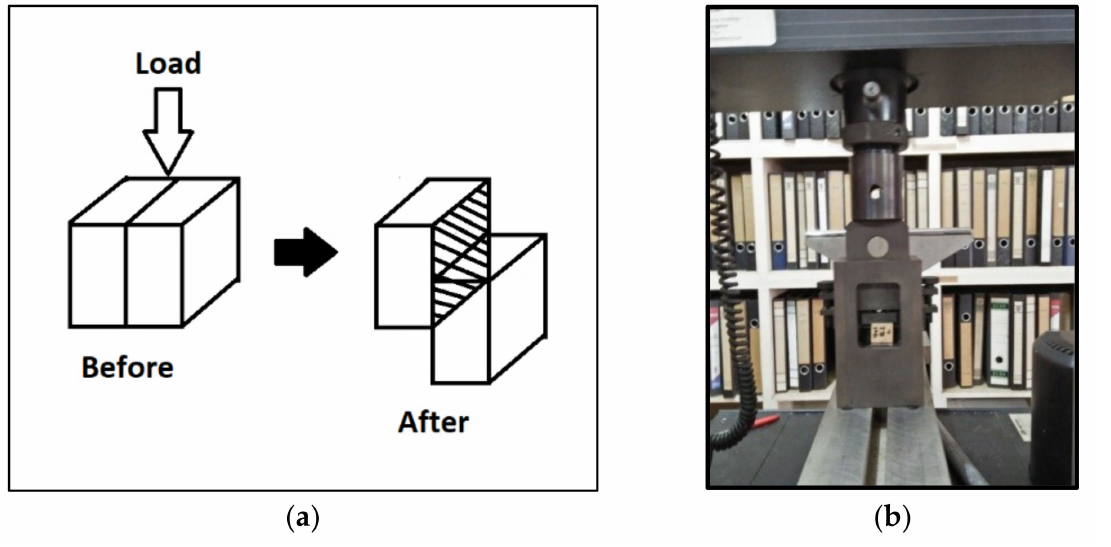
Figure 2. Shear parallel to grain test. ( a ) Shear parallel to grain test sample. ( b ) Measuring of the shear parallel to grain of an Acacia hybrid sample with universal testing machine Instron 5569, Norwood, MA, USA.